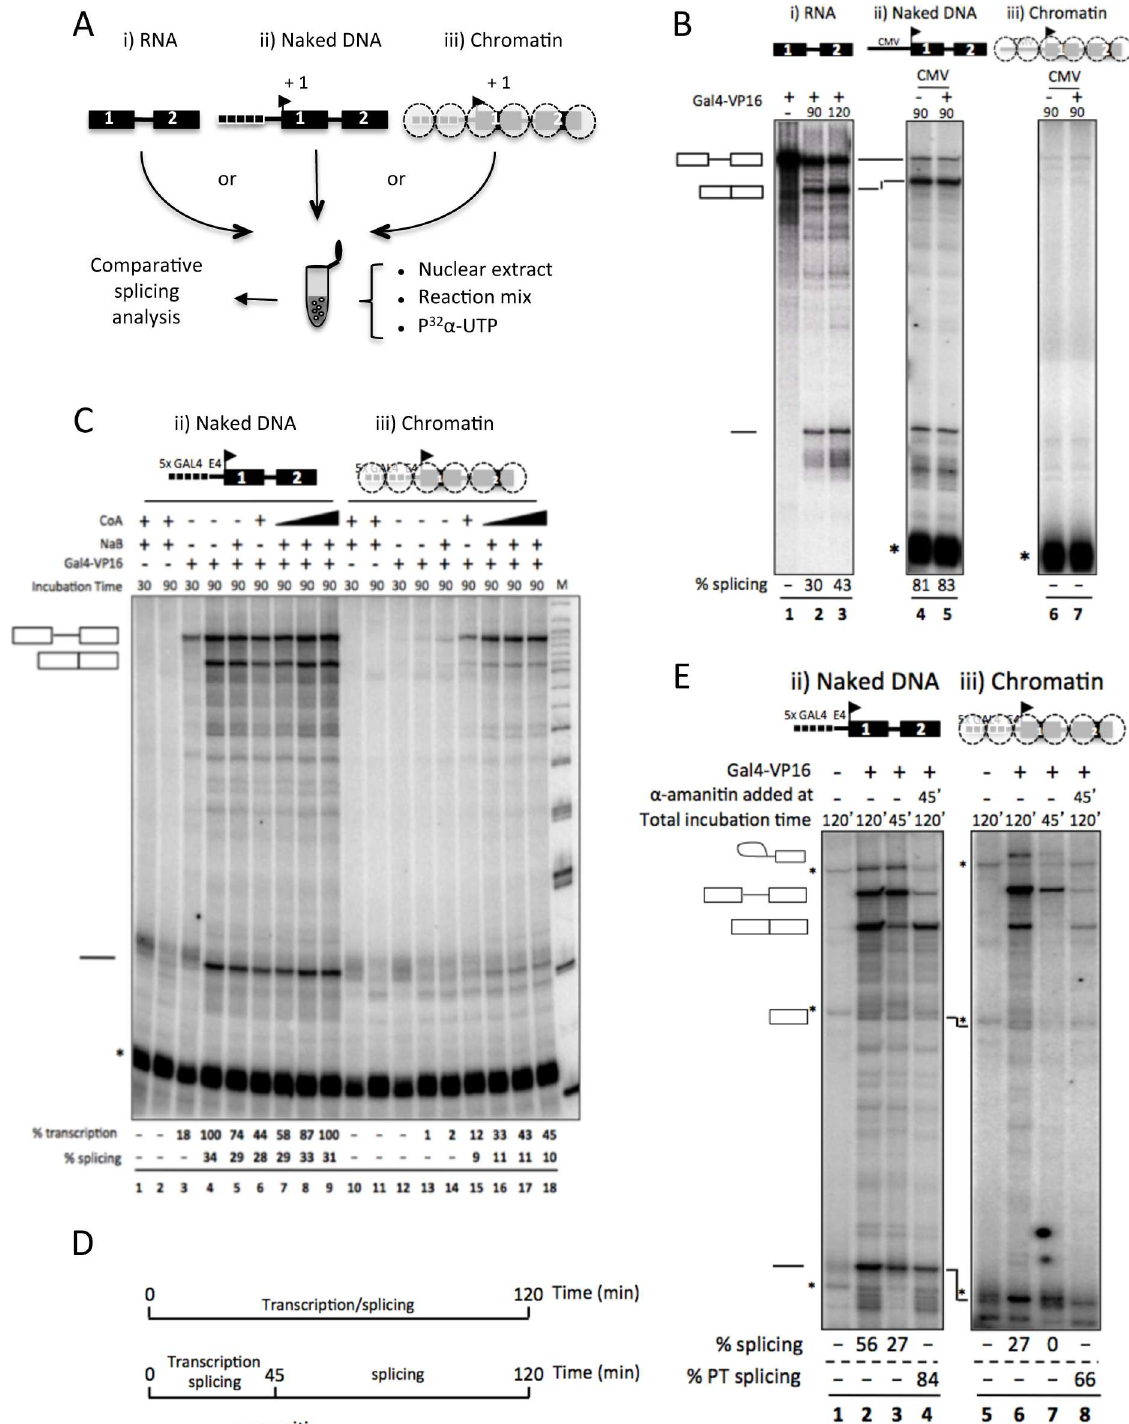
Fig 4. Chromatin affectsthe efficiency of intronremoval in vitro . (A) Diagram of the threedifferentsourcesof Ftz reporterRNA used to study in vitro the impactof chromatin on splicing.(i) A cappedpre-mRNAthat was independently transcribed with the T7 RNA polymerase before being added to HeLa nuclear extract; (ii)pre-mRNAwas transcribedin HeLa nuclear extract froma naked, or (iii)a chromatinized DNA template. Regardlessof the source, the pre-mRNAsare identical,with two exons and one intronoriginatingfromthe Drosophila Ftz pre-mRNA.(B) Analysis of the productsof in vitro splicing of the pre-synthesized